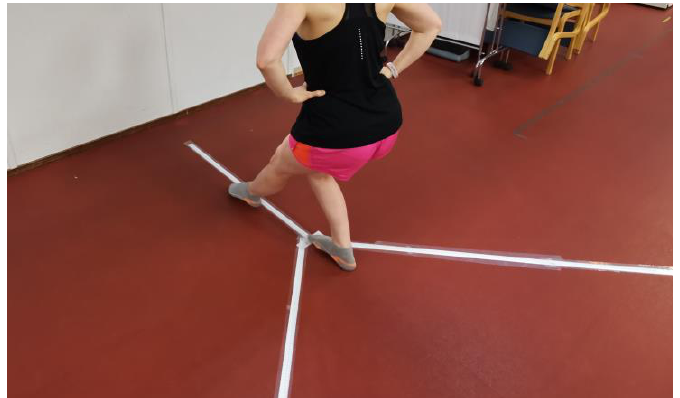
Figure 1. Measurement setup with the participant reaching in the anterior direction.